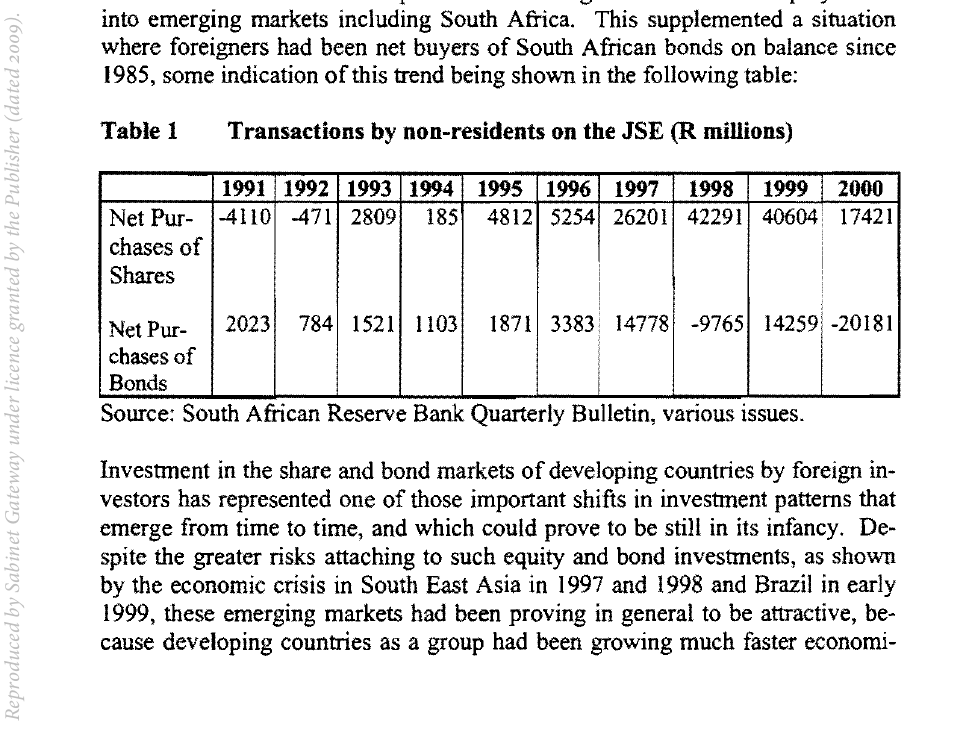
Transactions by non-residents on the JSE (R